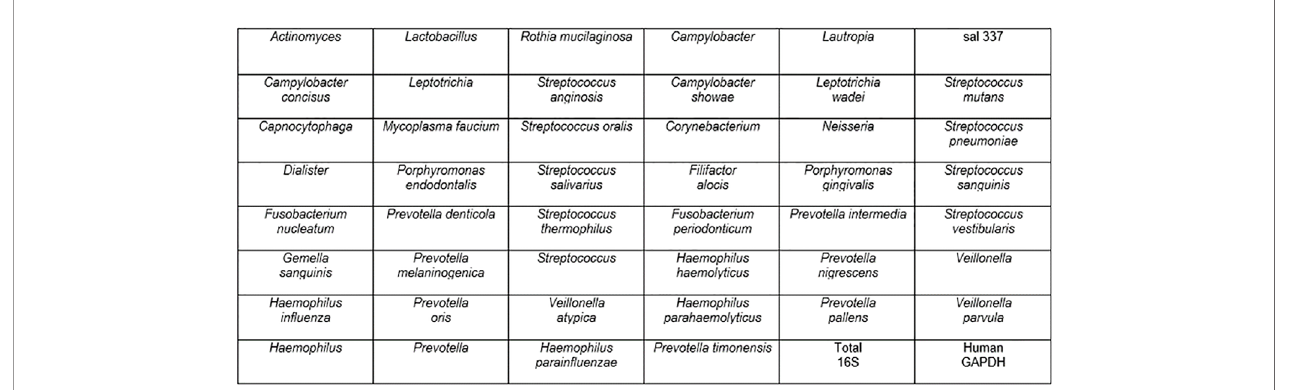
FIGURE 1 | Organisms on EMB